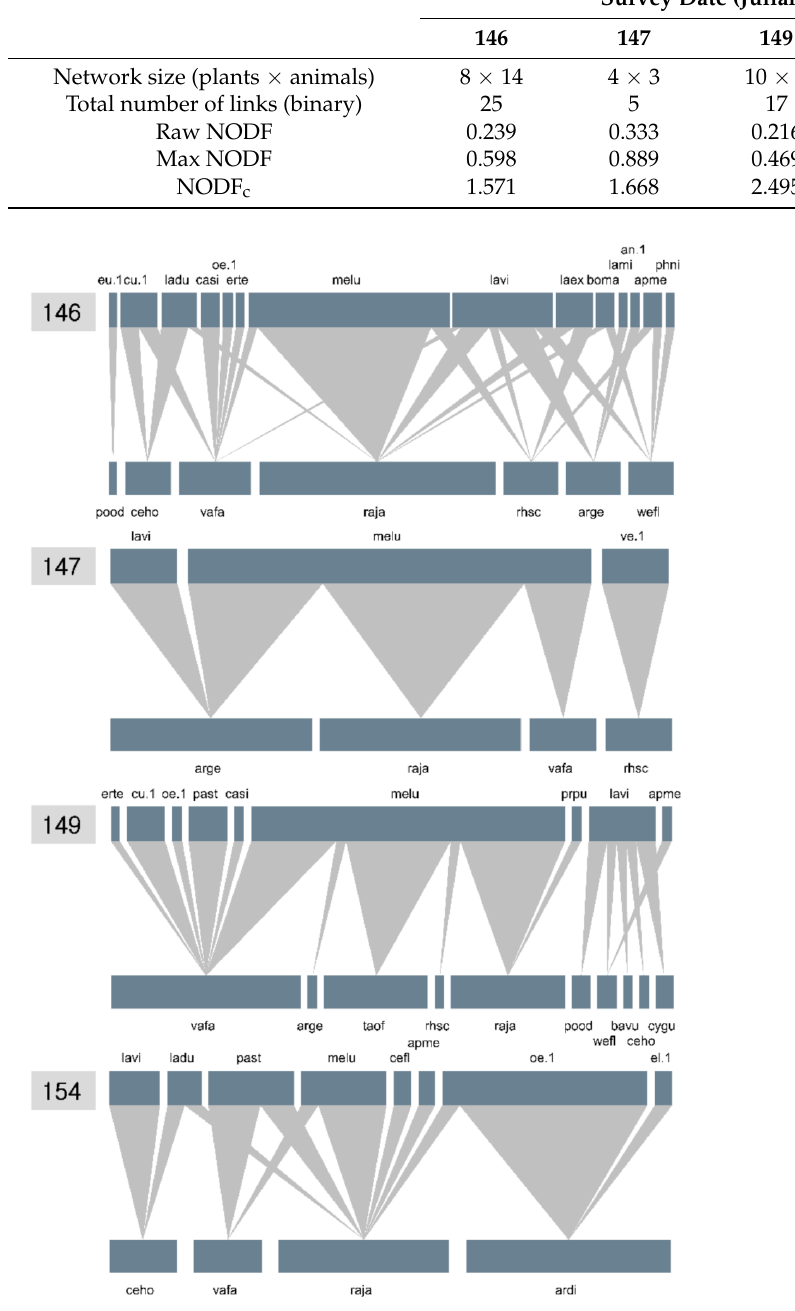
Figure 6. Daily networks of Cypripedium guttatum at the Manhangjae site in the Republic of Korea. The numbers on the upper-left side of each network indicate the days of the year. The acronyms for each network are shown in Figure